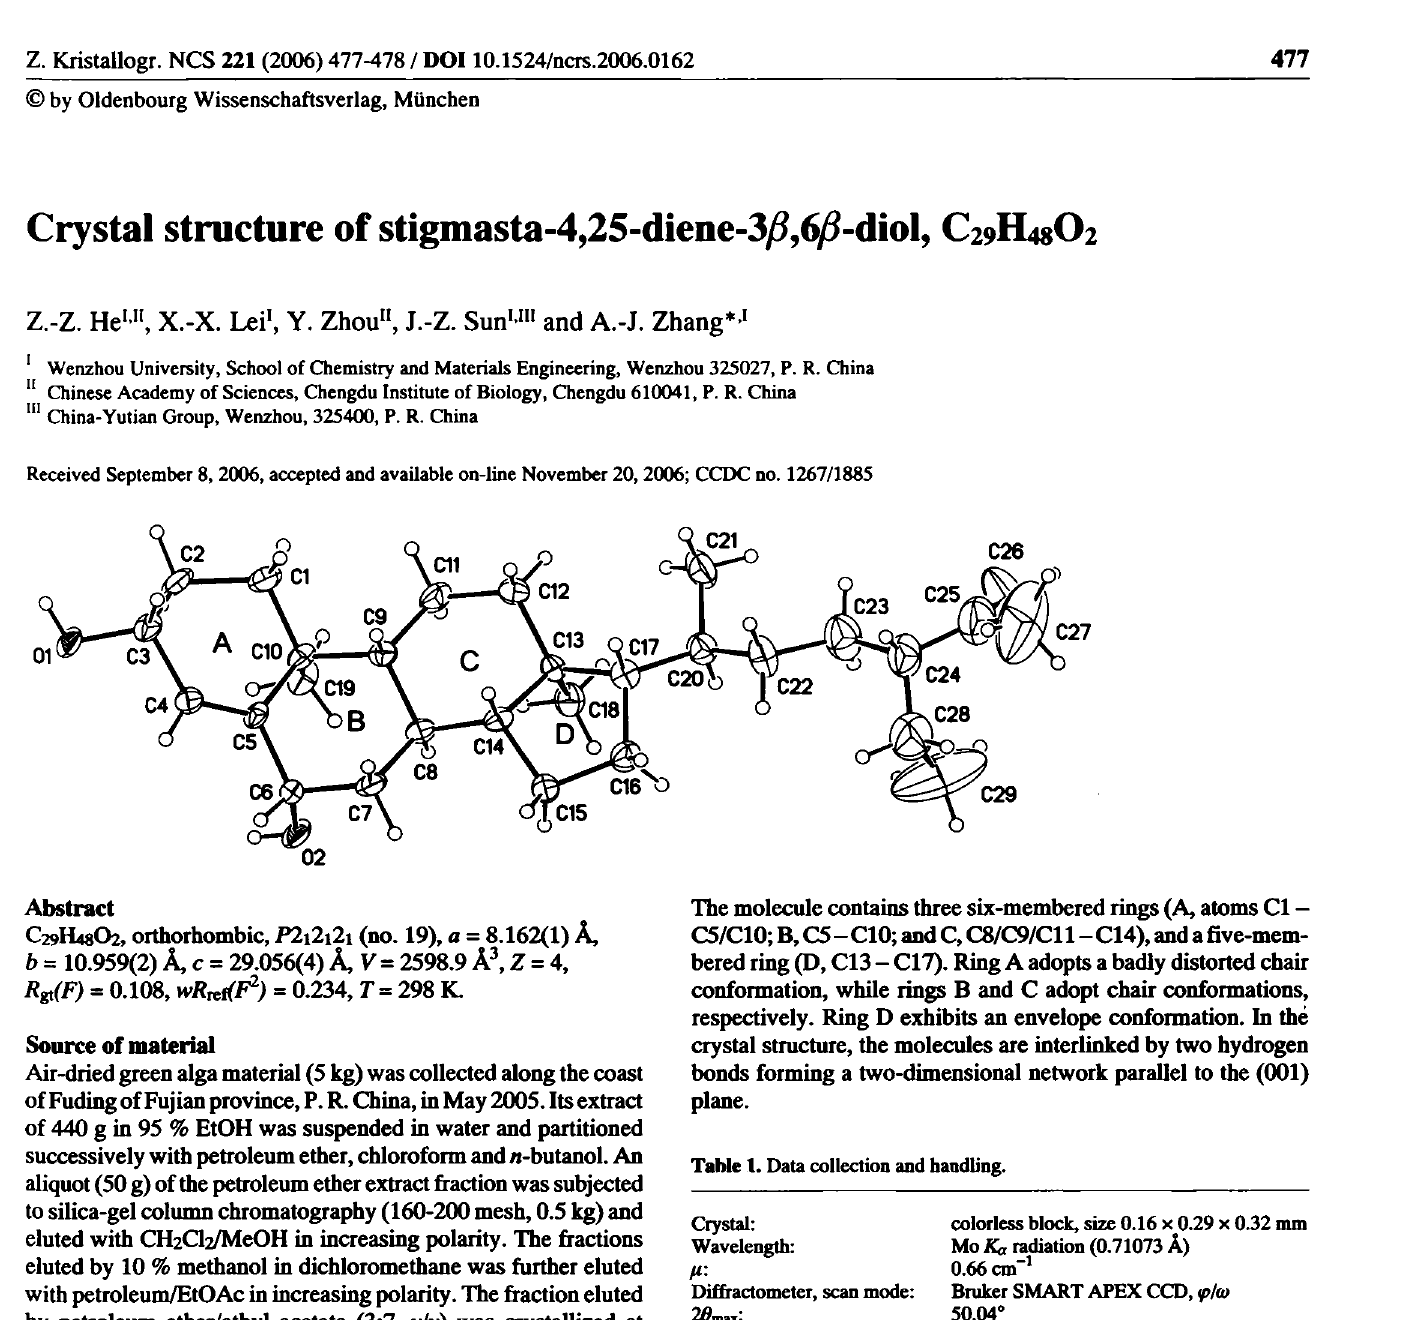
Table 2. Atomic coordinates and displacement parameters (in A 2